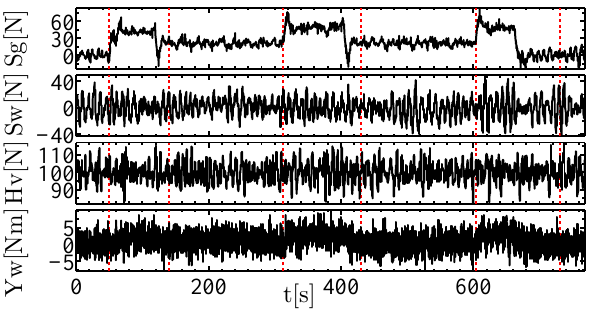
Figure 13: Characteristic functions and parametris- ation of the five parts of the reference path. The vertical dashed red lines separate each part of the path. The desired depth of 80 m was kept constant.